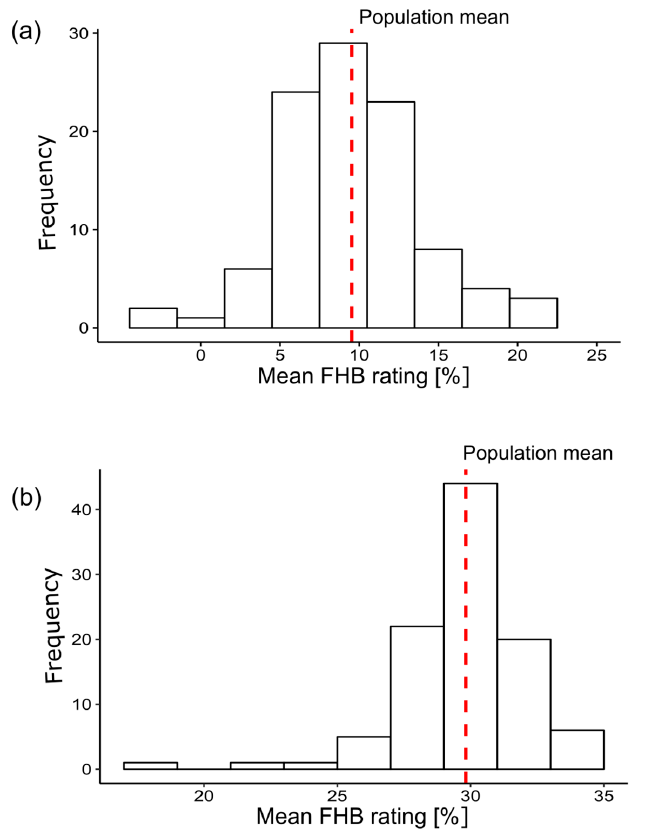
Figure 2. Histogram of the best linear unbiased estimators (BLUES) for mean Fusarium head blight (FHB) rating among 100 Fusarium culmorum isolates calculated across two years and two locations in ( a ) rye (2015 + 2016) and ( b ) wheat (2014 + 2015). The correlation of mean FHB aggressiveness on rye and wheat was significant (Figure 3).